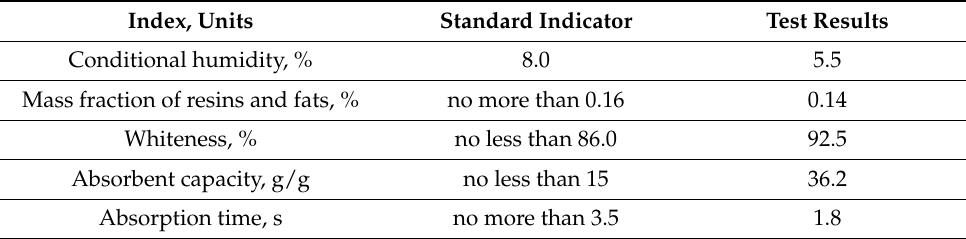
Table 2. Technical specification of fluff pulp sample of HogC .